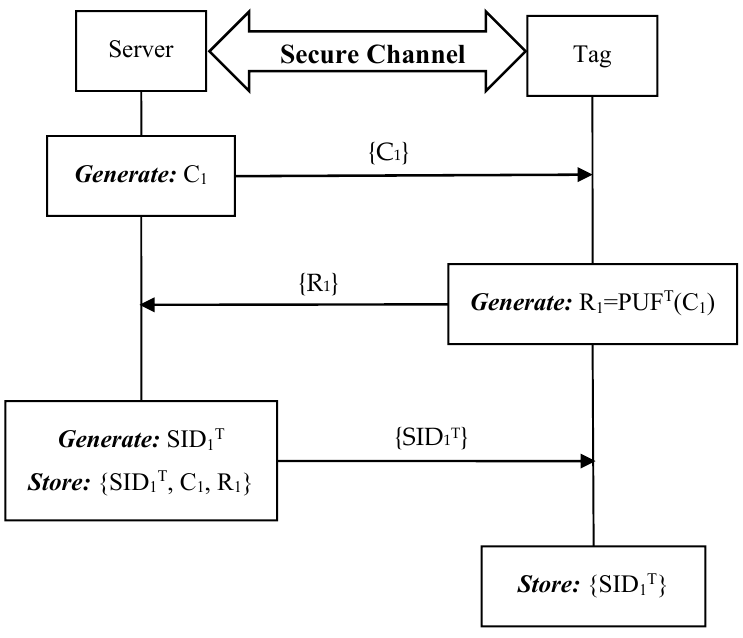
Figure 4. Setup phase of the proposed ideal PUF-based protocol.